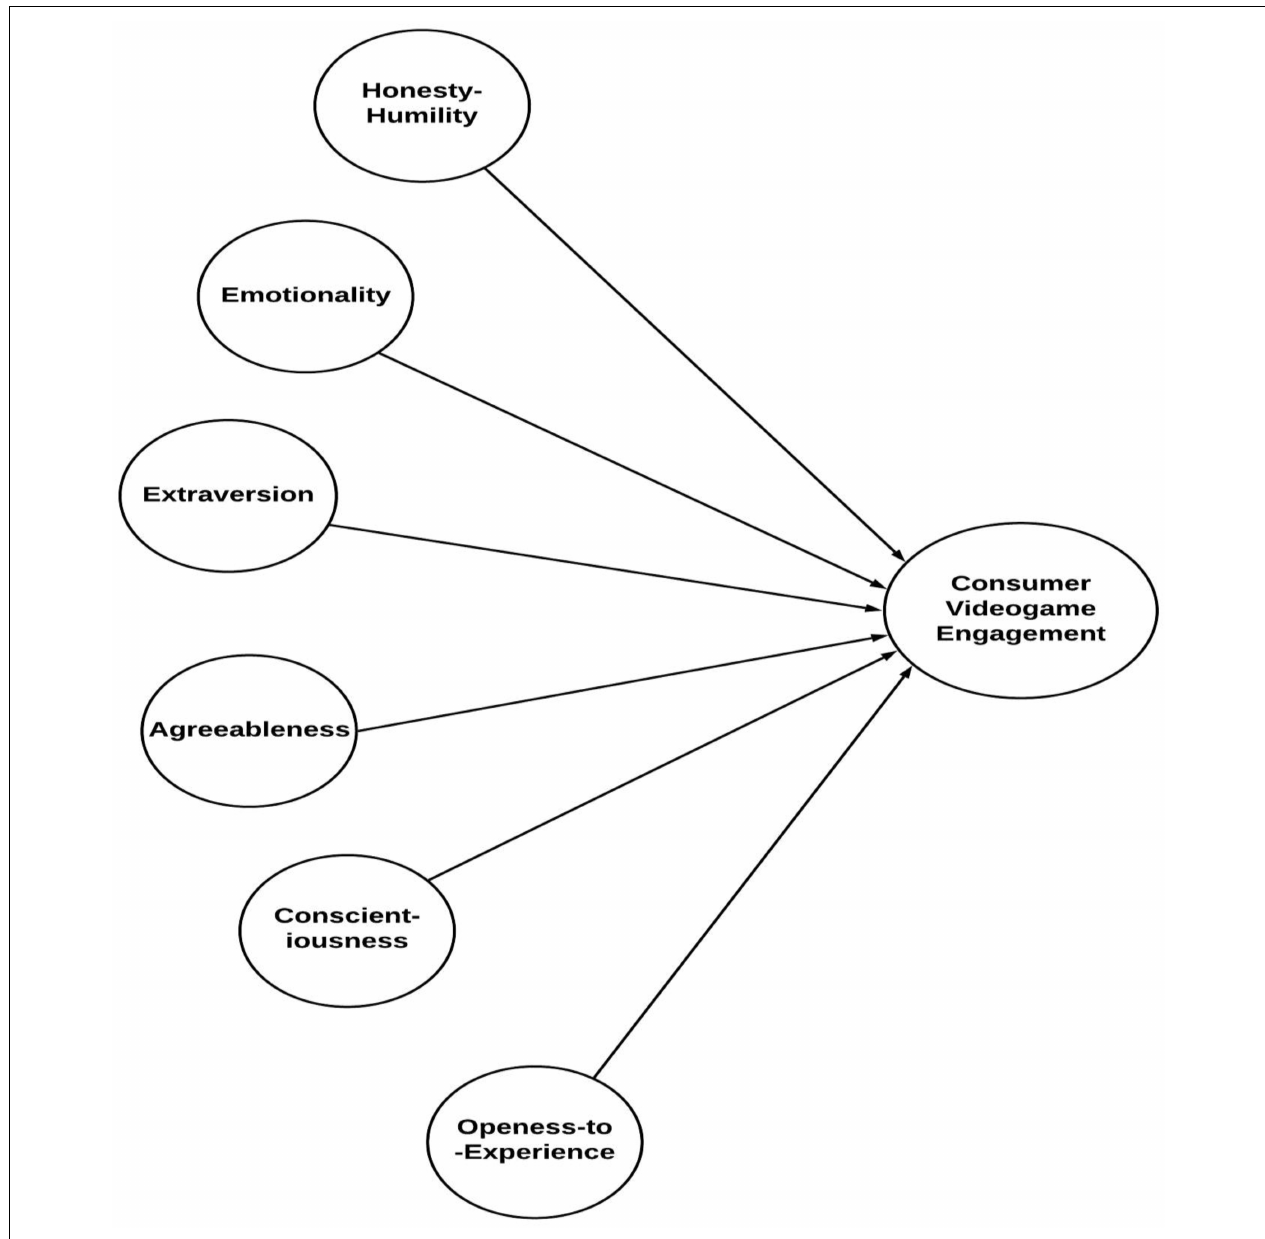
FIGURE 1 | Theoretical